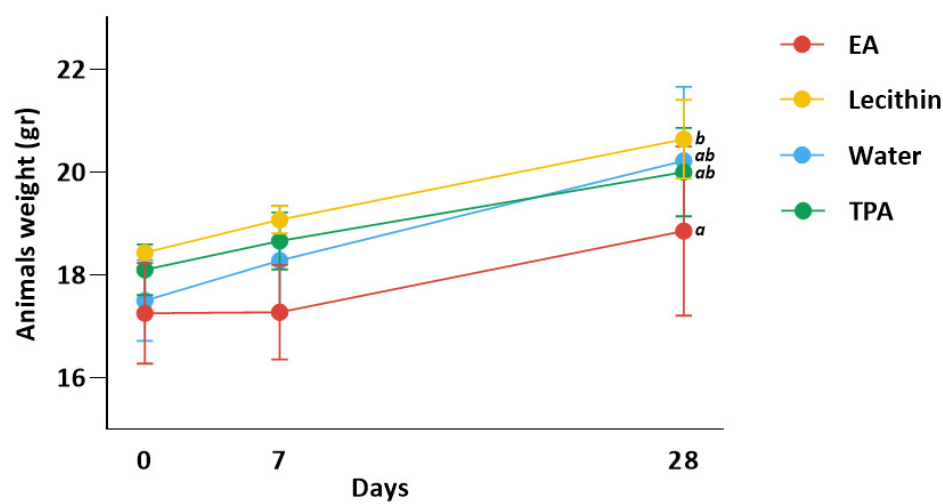
Figure 2. Change in animal weight after 7 and 28 days. Data represent means ± SD. ab Means at day 28 with different subscript letters are significantly different between groups. Specifically, the ANOVA test revealed a significant difference between the EA and lecithin groups at day 28 ( p -value < 0.05). Yet, there was no significant difference in mean weight between the EA and TPA groups.